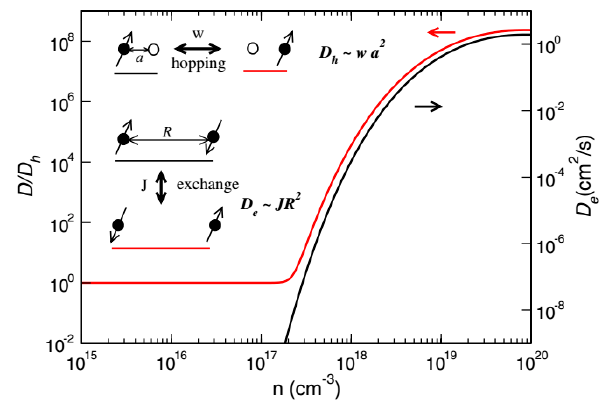
Figure 26. Relationship between the spin diffusion (SD) constant and polaron density by Yu et al. [88] with the permission of Physical Review Letters. Black and red (gray) lines are D e and D / D h respectively, where D h = ν h k B T / e and ν h = 10 − 6 cm 2 / s . The inset illustrates hopping-induced and exchange-induced and solid (open) circles represent occupied (vacant) sites.